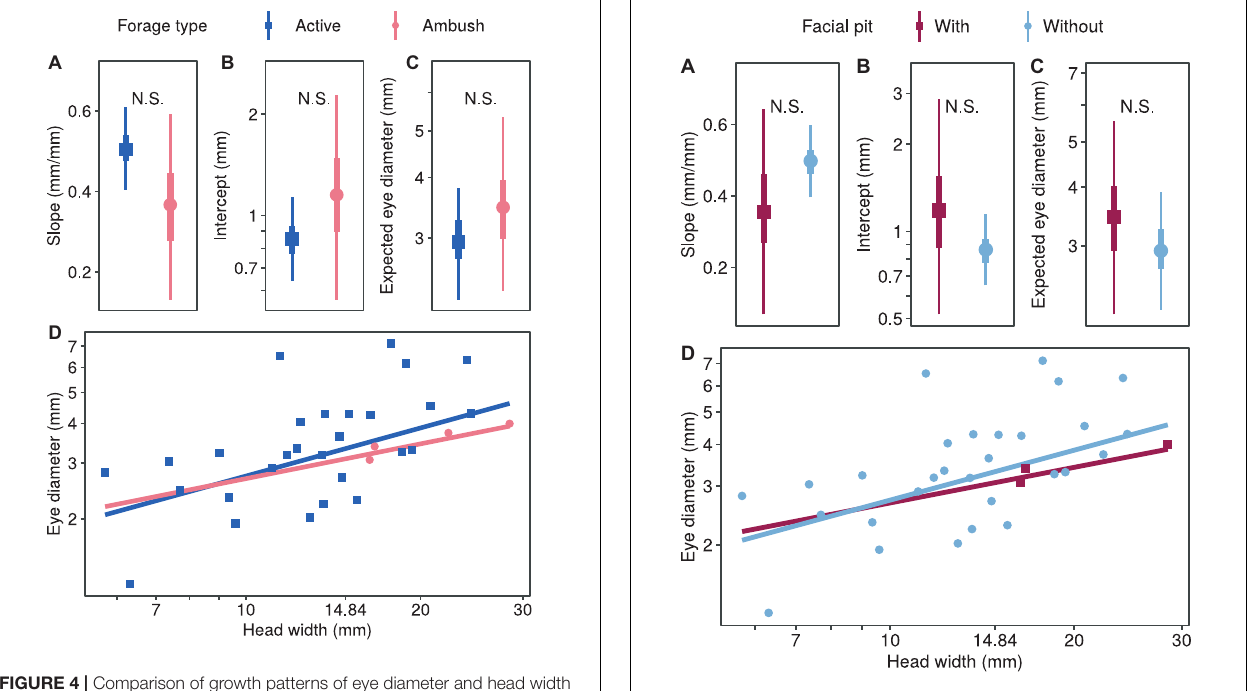
FIGURE 5 | Comparison of growth patterns of eye diameter and head width with and without pit, including allometric growth index (A) , proportionality coefficient (B) , expected eye diameter (C) and scatter diagram (D) . In subplots (A–C) , the symbols, vertical thick lines and vertical thin lines indicate the median, 50 and 95% HDI of the posterior distribution, respectively, and lowercase letters indicate multiple comparisons between groups (not having the same letter indicates a significant difference), while N.S. indicates no statistical difference. In (D) , the points indicate the mean head width and eye diameter within each